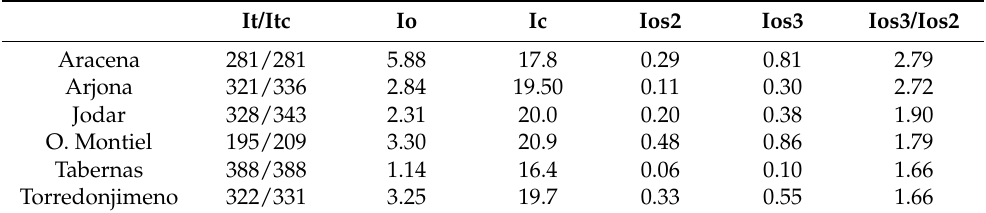
Table 2. Values of indices for the comparative analysis between meteorological stations: It/Itc = thermicity index and compensated thermicity; Io = ombrothermic index; Ic = continentality index; Iosc2, Iosc3 = summer ombrothermic index.